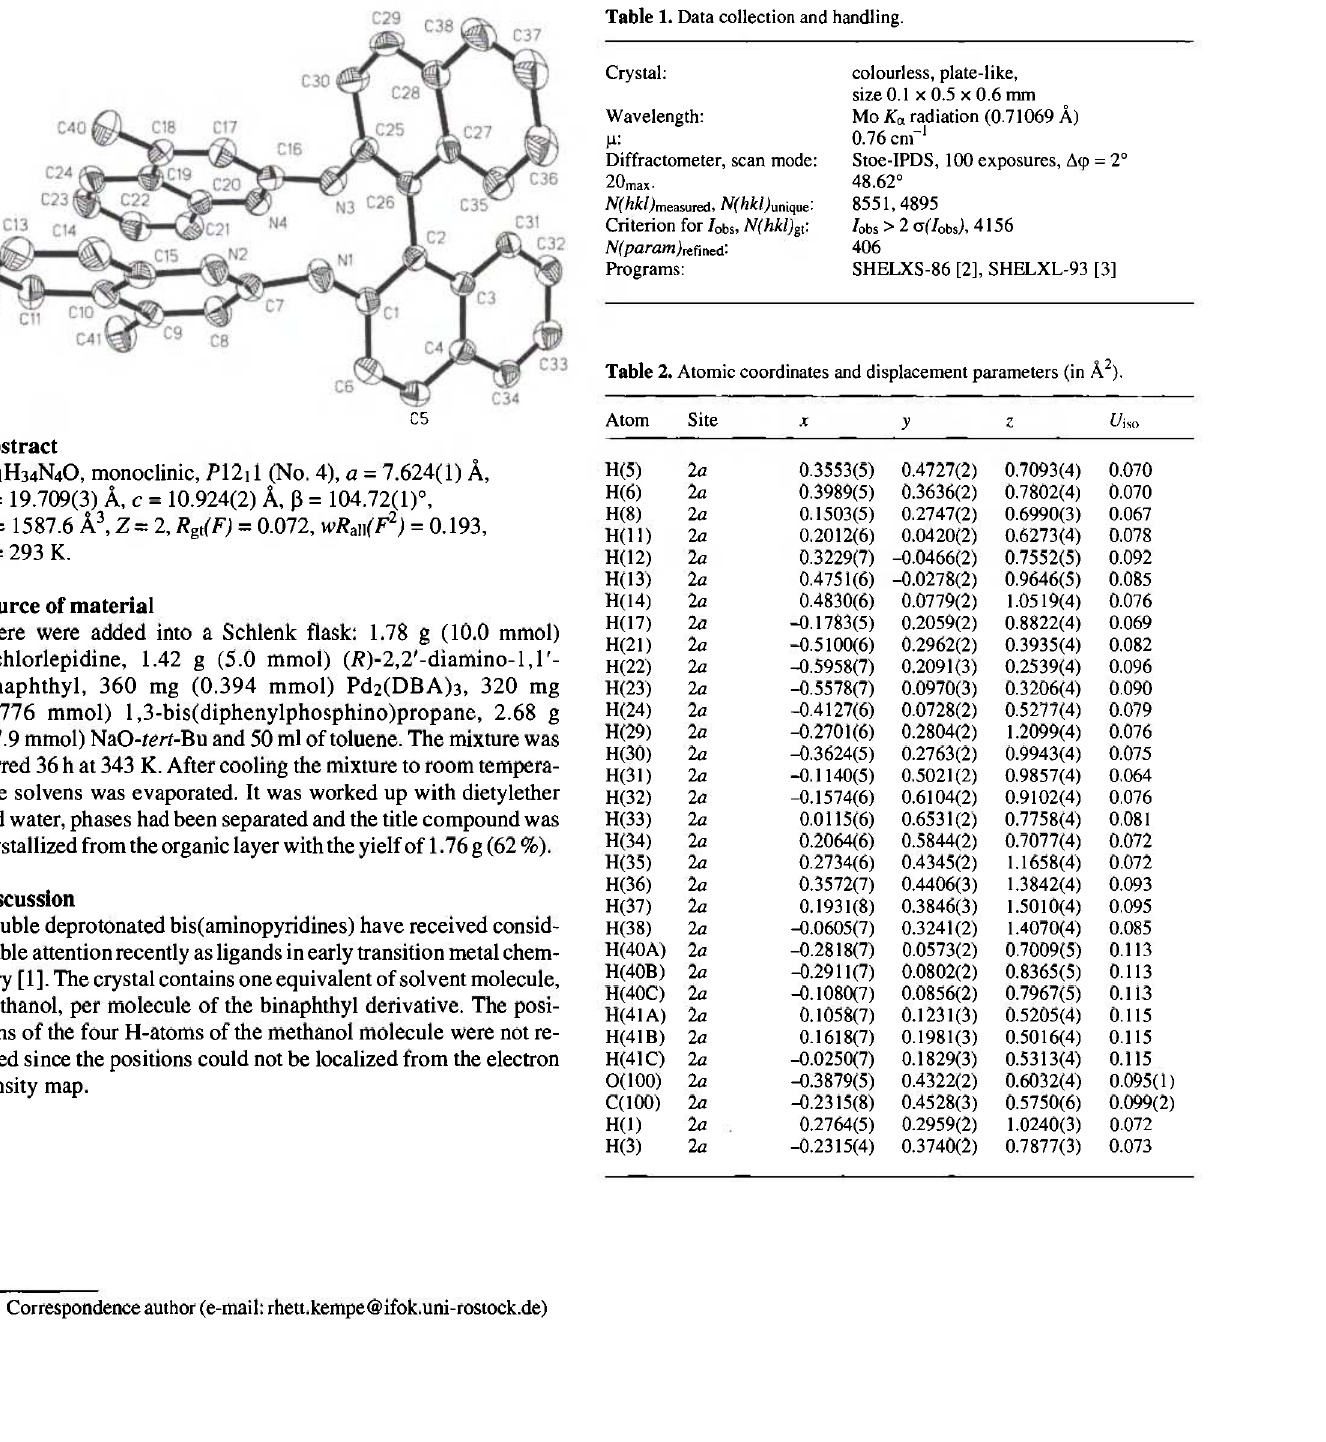
Table 1. Data collection and handling.